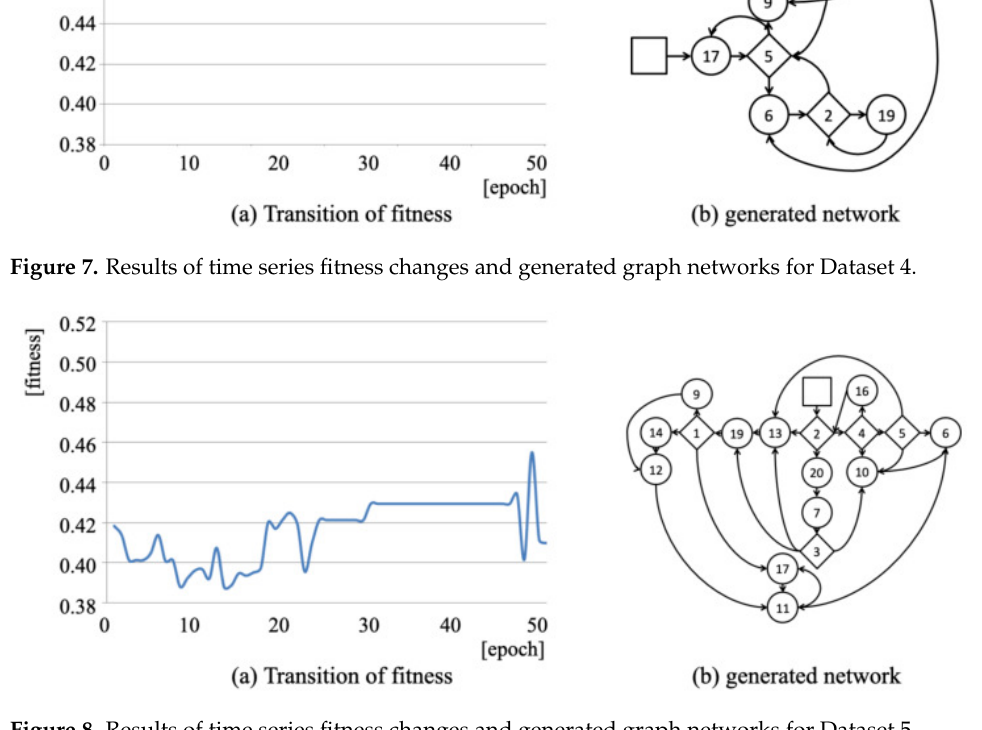
Figure 8. Results of time series fitness changes and generated graph networks for Dataset 5.